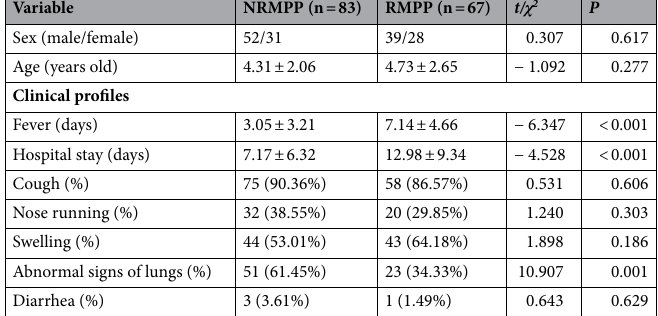
Table 1. Comparison of demographic data and clinical characteristics between NRMPP and RMPP.